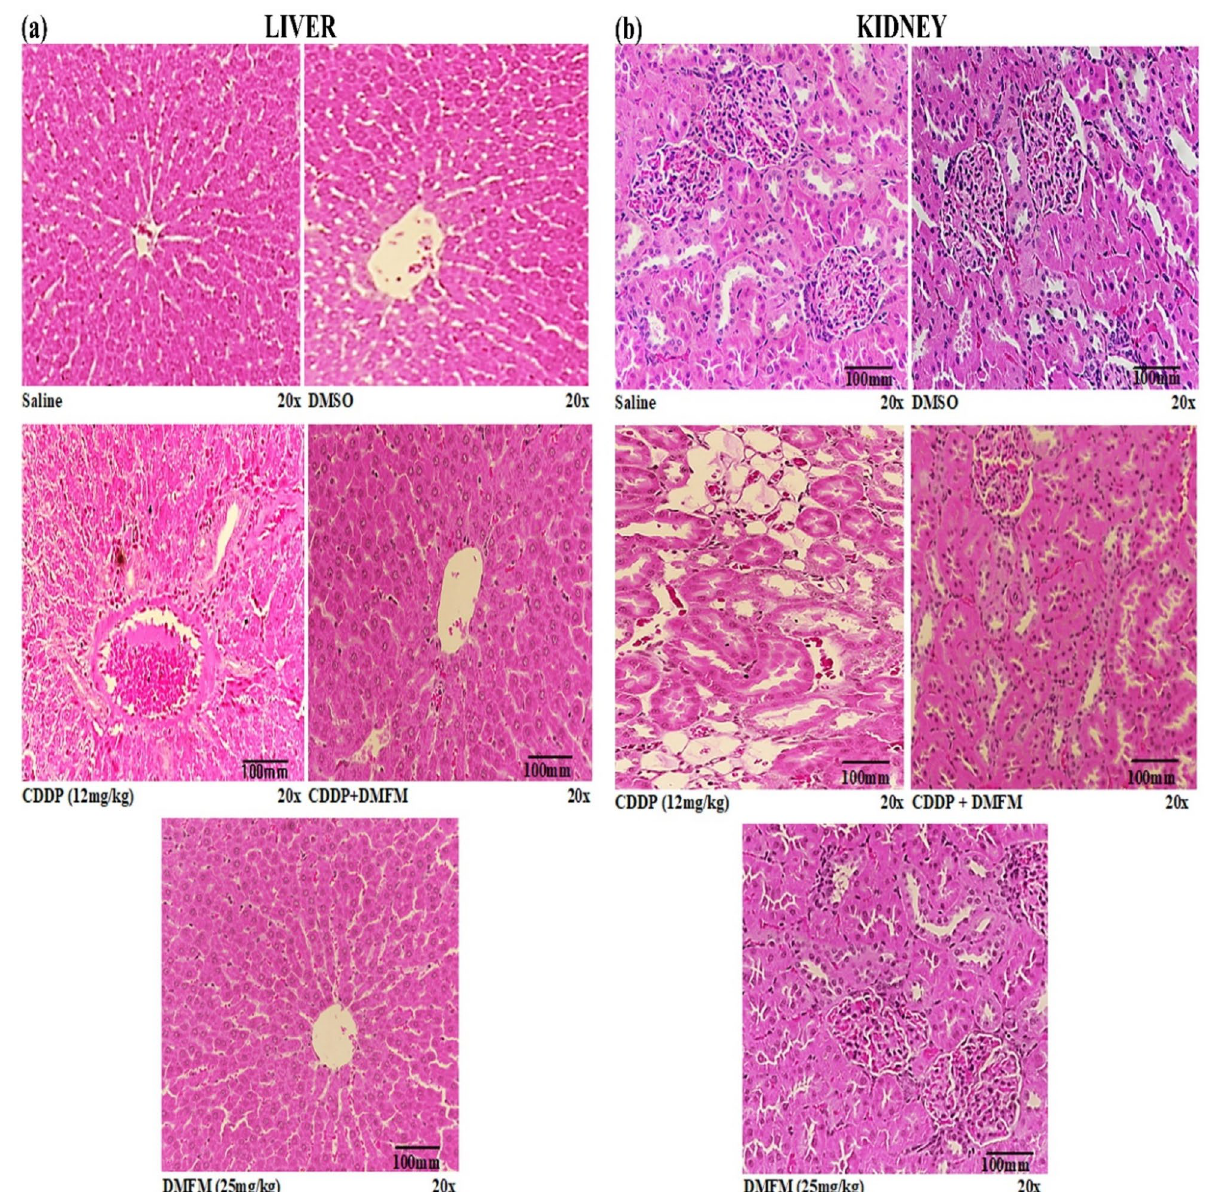
Figure 7. Representative H & E images of rat liver and kidney from all treatment groups. ( a ) Liver tissue sections from saline and DMSO groups present a typical hepatic structure. CDPP-treated liver sections revealed higher cellular lacerations, structural derangements, and assembly of inflammatory cells. DMFM + CDDP treated liver sections showed near to normal morphology. DMFM treatment showed normal morphology as in control rats. ( b ) Kidney section from saline and DMSO groups showing normal kidney morphology. CDPP- treated rat kidney section showing enhanced cellular lesions, ballooning, and collection of inflammatory cells. DMFM + CDDP treated sections with minor tubular deteriorations. DMFM alone treatment showed normal morphology as in control rats. Treatment conditions are indicated at the lower left of each